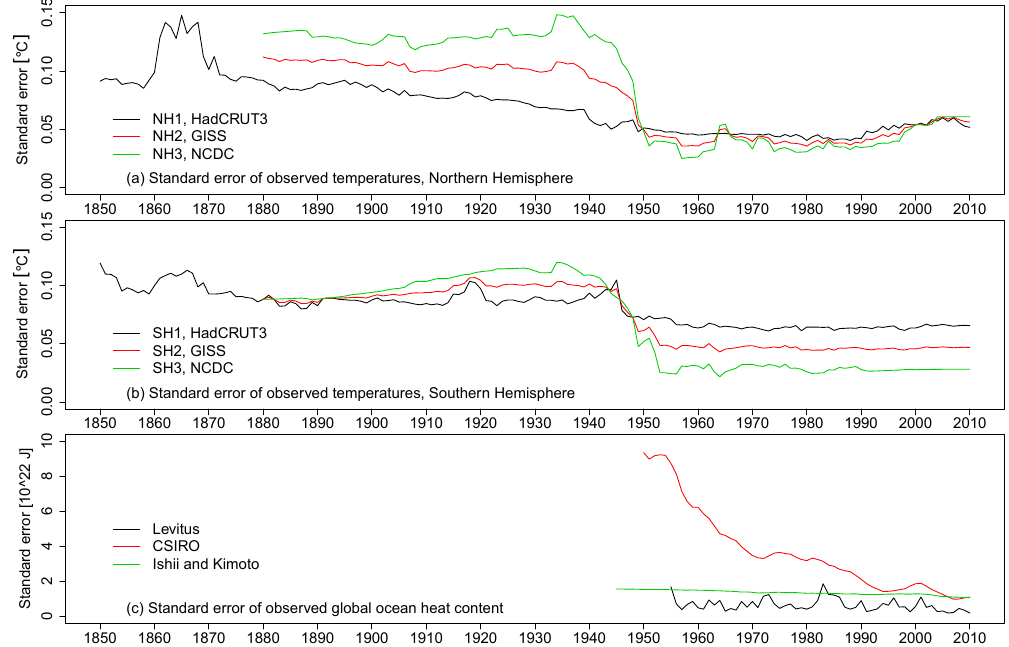
Fig. B3. Reported standard errors of annual temperature and ocean heat content data. The standard errors for the Goddard Institute for Space Studies (GISS) series are simply computed as the middle of the standard errors for the two other series. HadCRUT3, University of East Anglia and the Hadley Centre; NCDC, National Climatic Data Center; CSIRO, Commonwealth Scientific and Industrial Research Organisation.